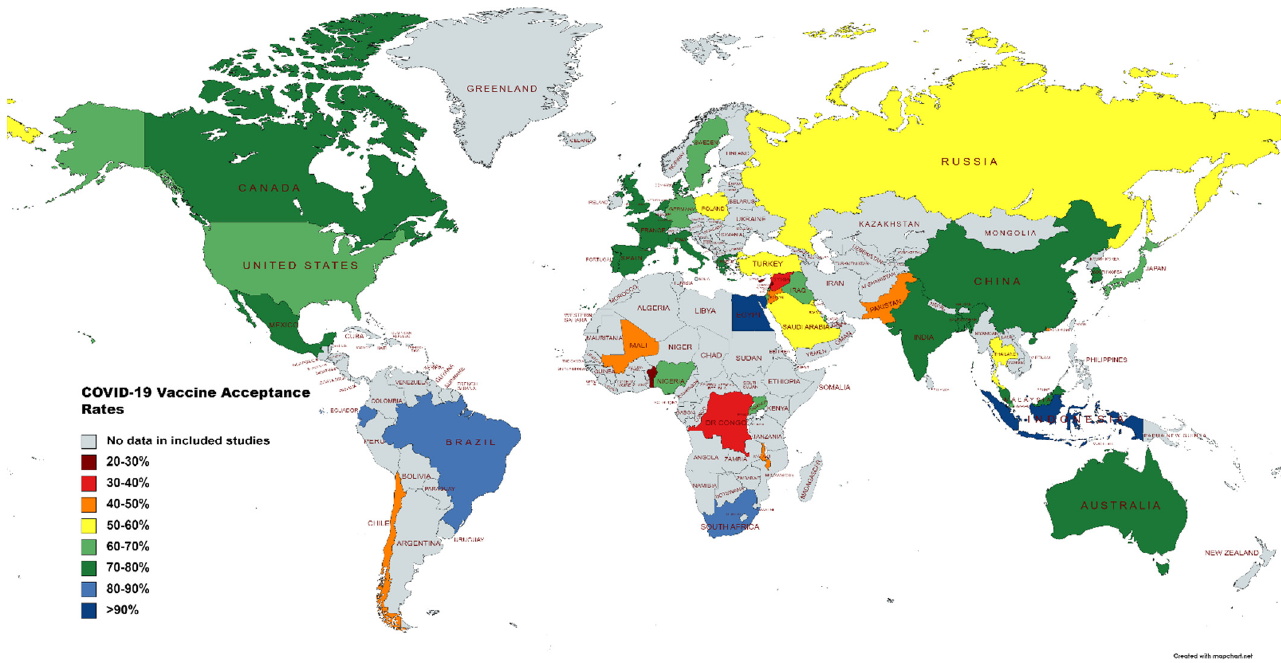
Figure 2. Map illustrating vaccine-acceptance rates worldwide.